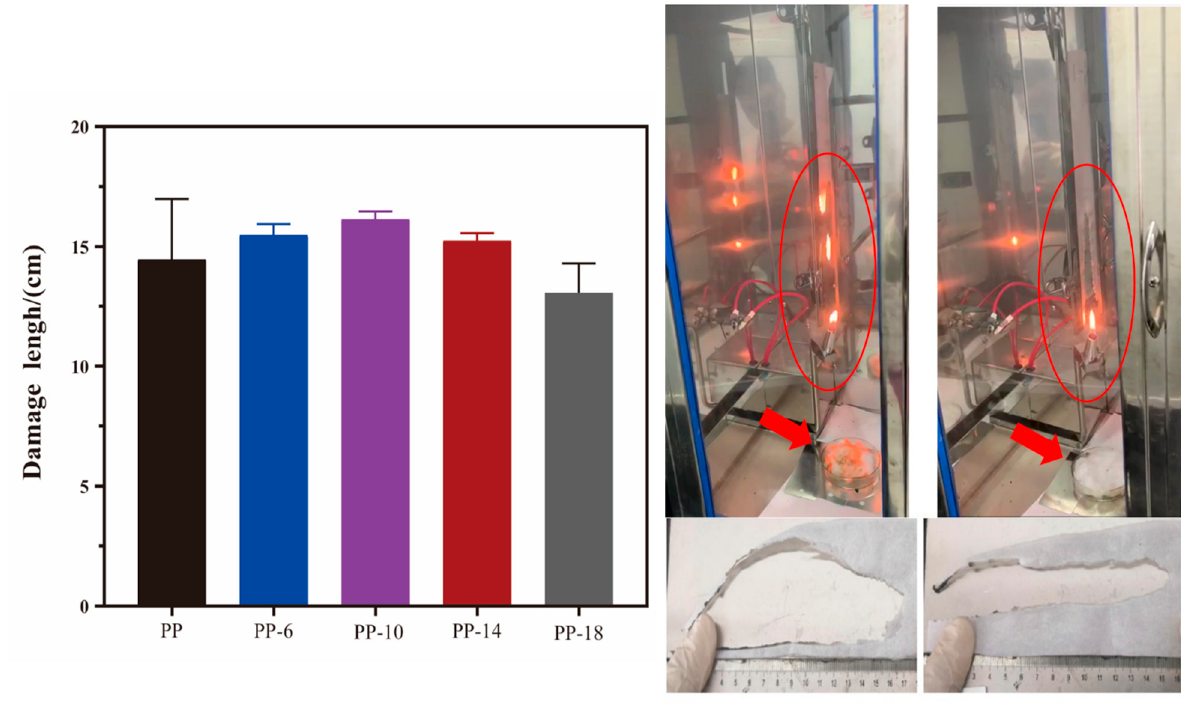
Figure 4. Diagram and images for vertical combustion damage